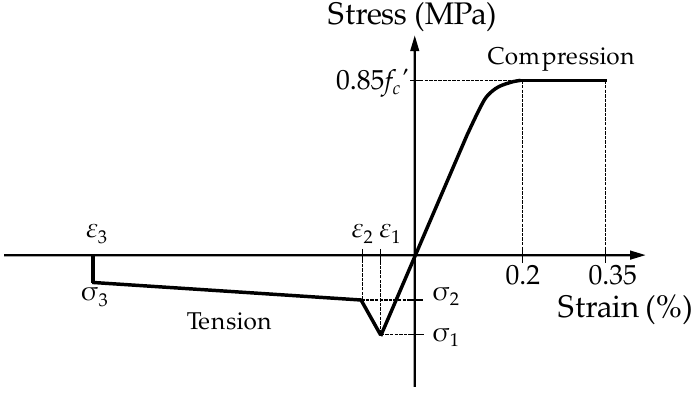
Figure 12. Material model for sectional analysis.